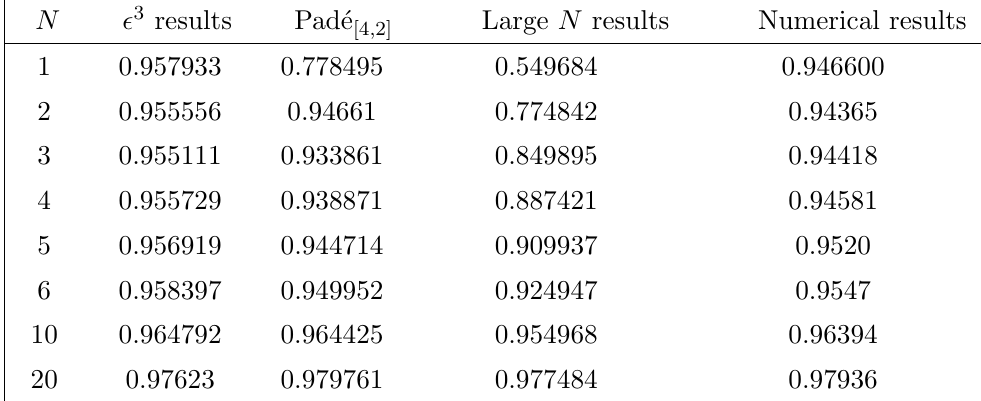
Table 1 . The values of (cid:15) 3 , Pad(cid:19)e approximants Pad(cid:19)e sults [95] for c T =c T in d = 3 for the O ( N ) model. free